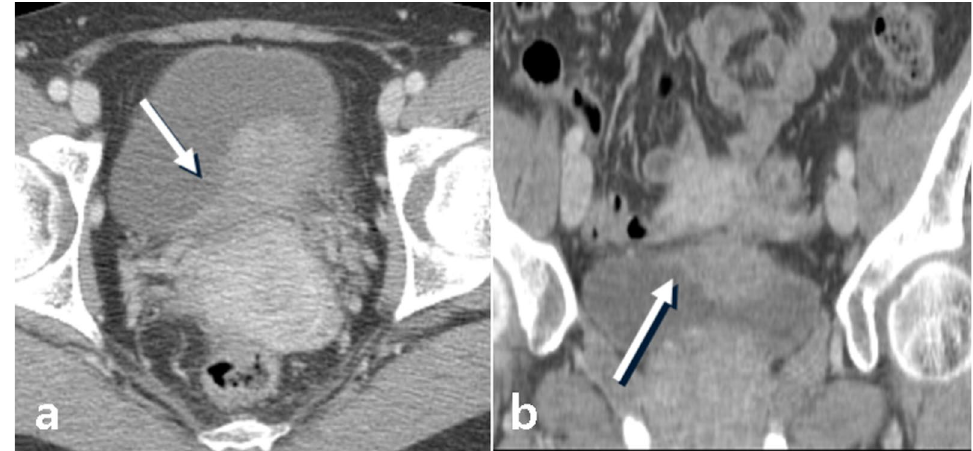
Fig. 10 A 37‑year‑old female patient with bladder endometriosis. Axial ( a ) and coronal ( b ) urothelial phase CT images showing a solid, well‑marginated enhancing mass at the dome of the bladder. Note the obtuse angle of the mass from the bladder wall